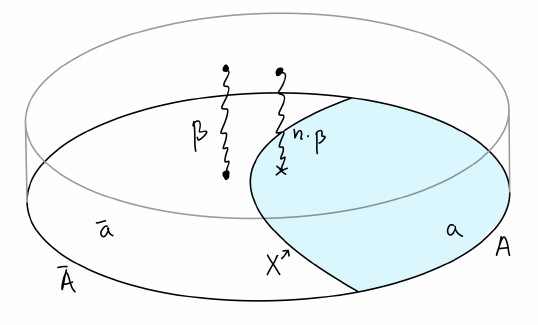
Figure 9 . The string theory n replicas construction in thermal AdS, for near-horizon temperatures. In blue, the bulk replica surface a . The winding string in a winds through all the n replicas. As a result, the first winding mode has a mass m 2 ( n · R ) . For each replica, the first winding mode in the complement ¯ a has a mass m 2 ( R )